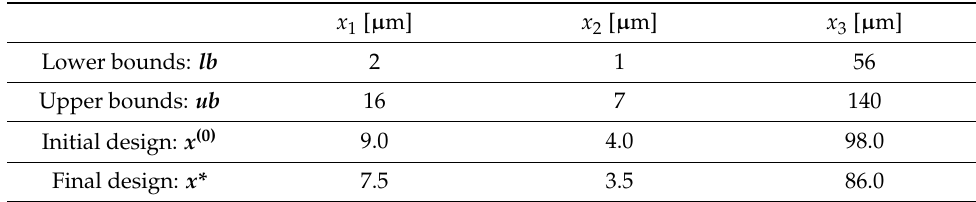
Table 3. Design example no. 1 summary: lb , ub , x (0) , and x *.